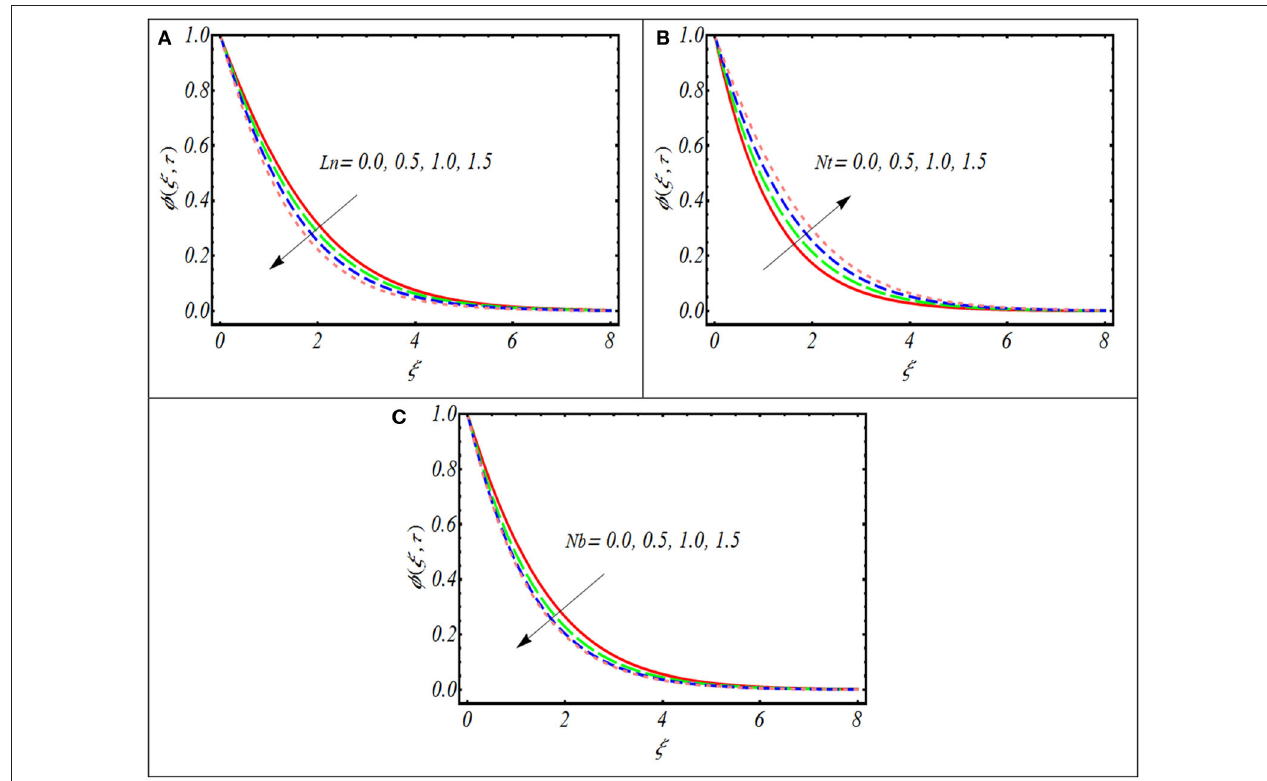
FIGURE 6 | Impact of (A) Ln , (B) Nt , and (C) Nb .